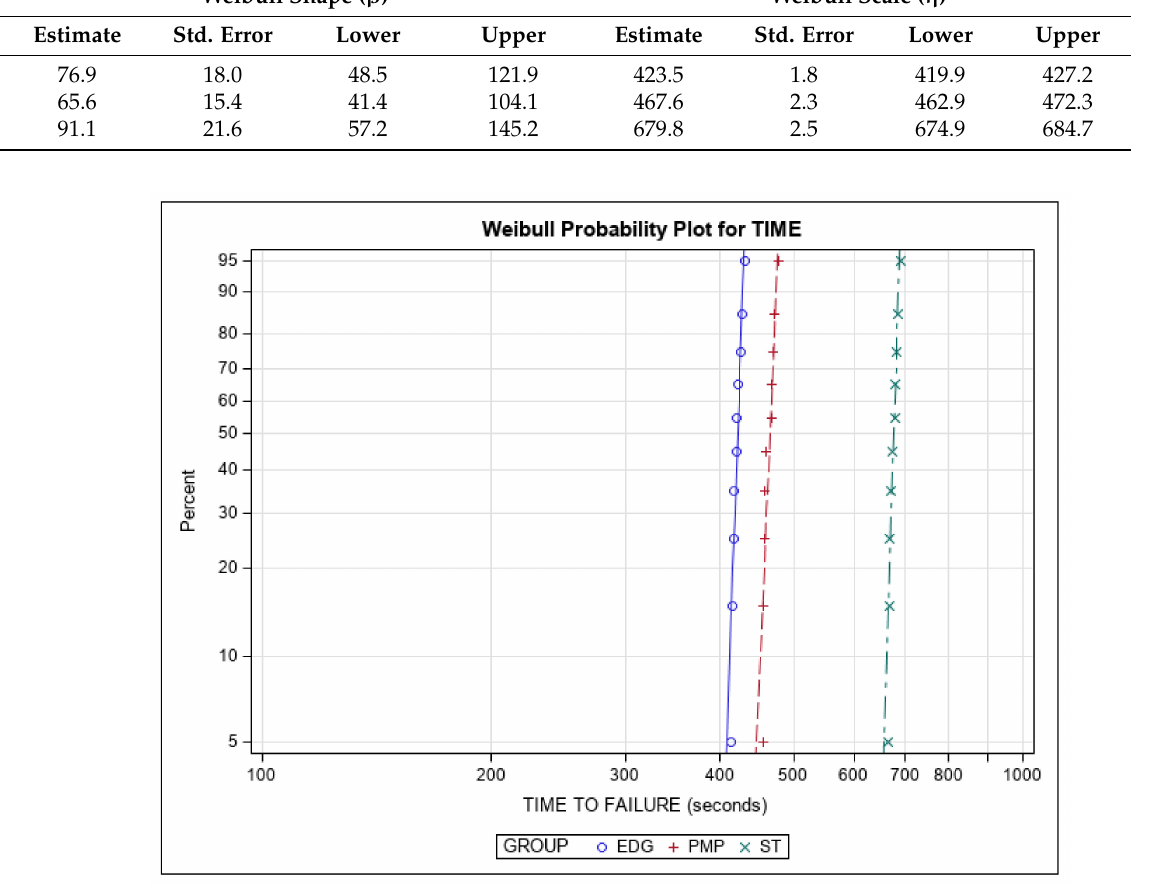
Figure 7. Weibull probability plot of time to failure for the EDG, PMP, and ST novel brands of NiTi alloy endodontic